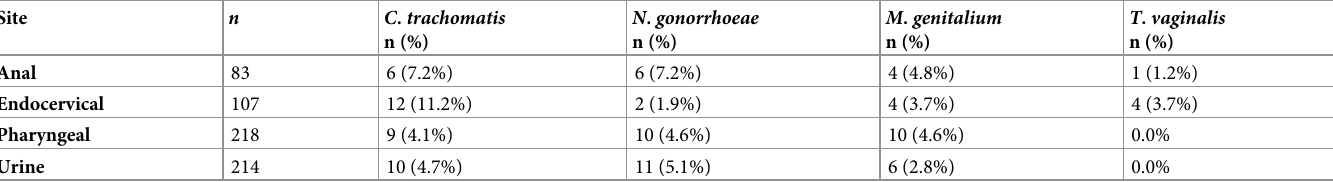
Table 3. Anatomical distribution and prevalence of the Aptima 1 -positive samples.